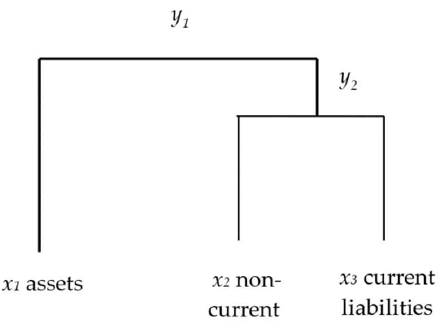
Figure 6. Tree diagram